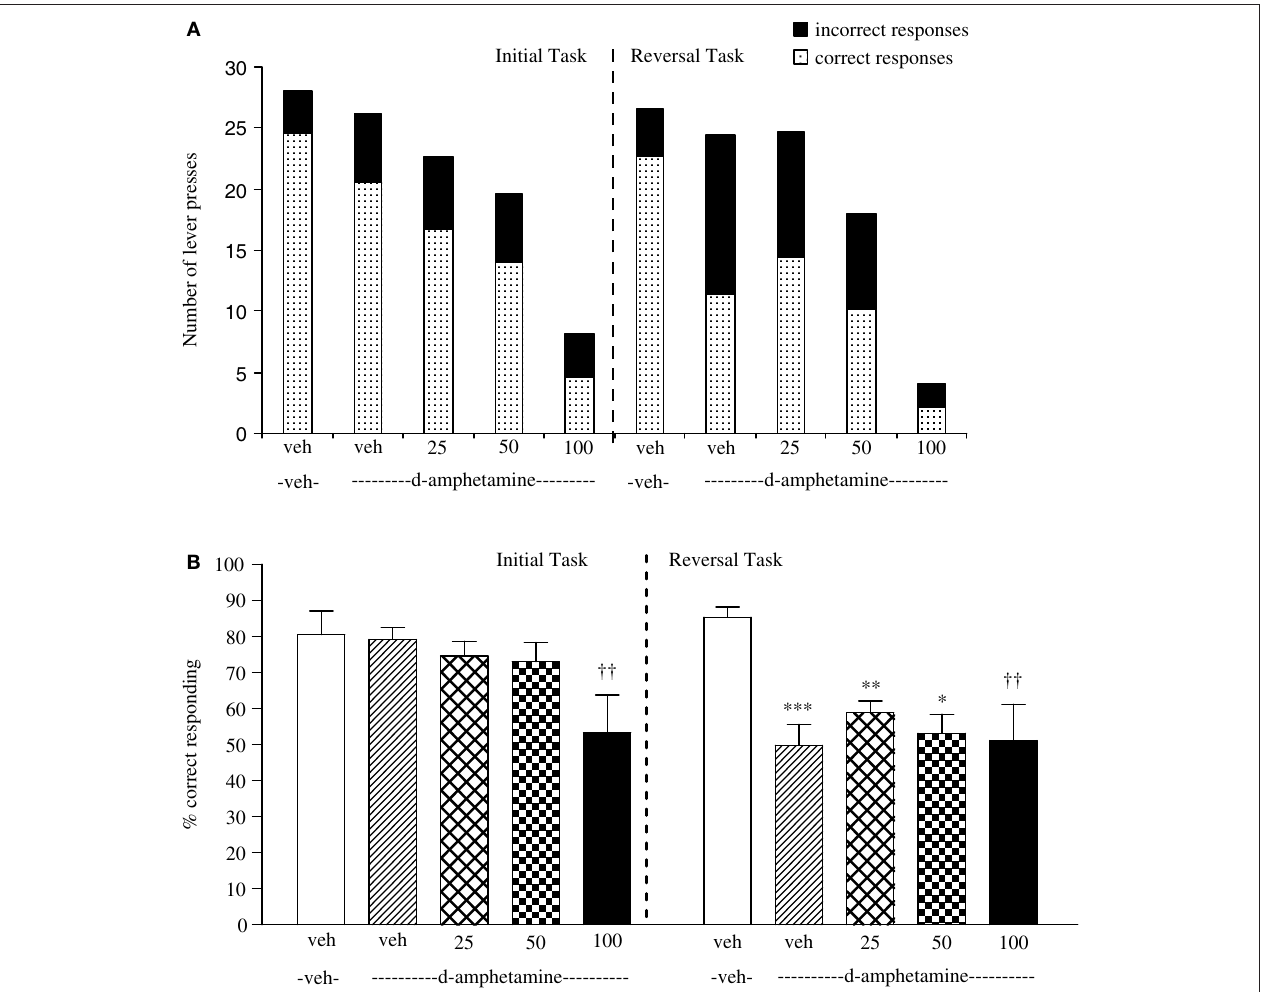
FIGURE 3 | (A) The effect of phenytoin pretreatment (25–100 mg/kg, i.p.) on the defi cit produced by D -amphetamine (0.5 mg/kg, i.p.) on performance of the initial and reversal phase of the reversal learning task. Data are shown as the mean total number of lever presses, correct responses are shown as clear bars and incorrect responses are shown as shaded bars ( n = 8 per group). (B) The effect of phenytoin pretreatment (25–100 mg/kg, i.p.) on the defi cit produced by